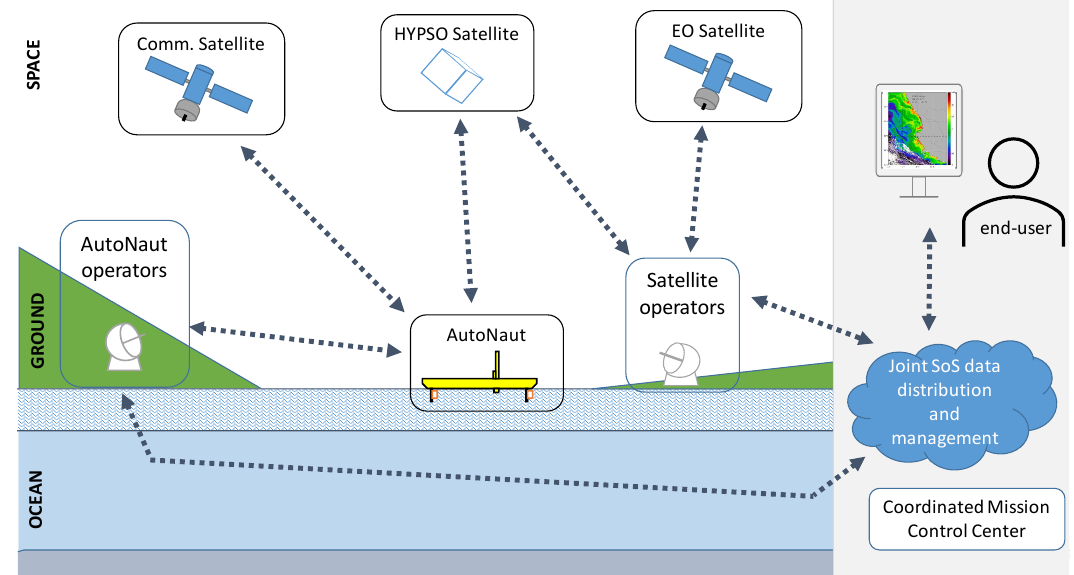
Figure 2. Proposed system architecture.